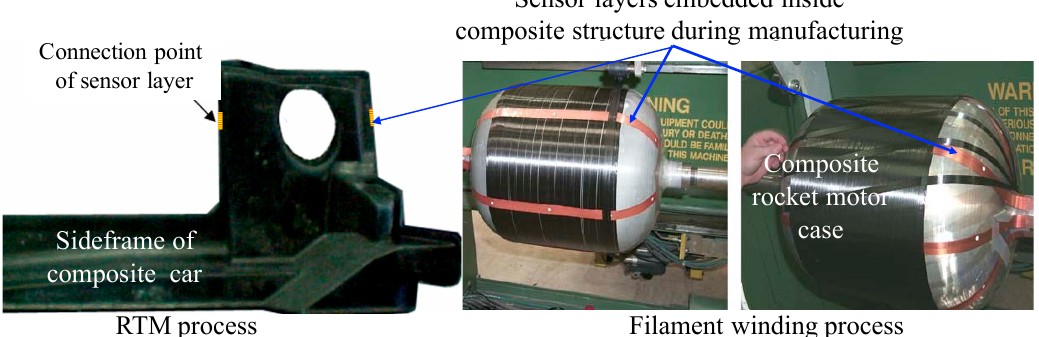
Figure 4. Sensor layers embedded inside composite structure during different manufacturing process (adapted from [18,19]).